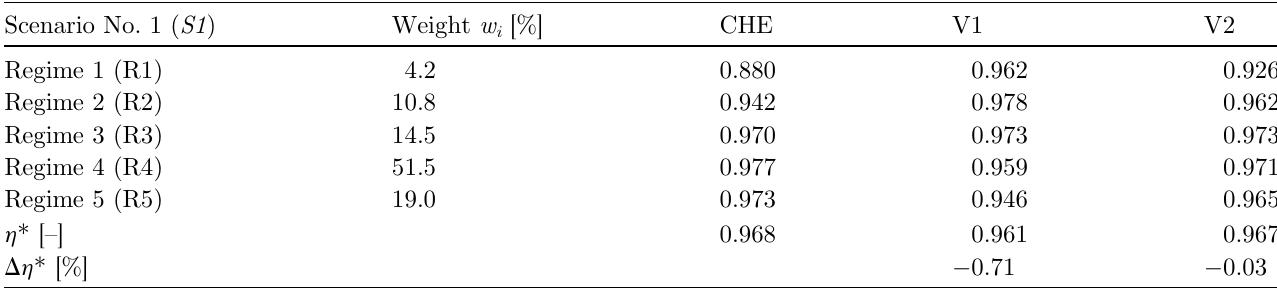
Table 2. The hydraulic ef fi ciency for each solution and the ef fi ciency gain with respect to the existing one in scenario No. 1 ( S1 ).